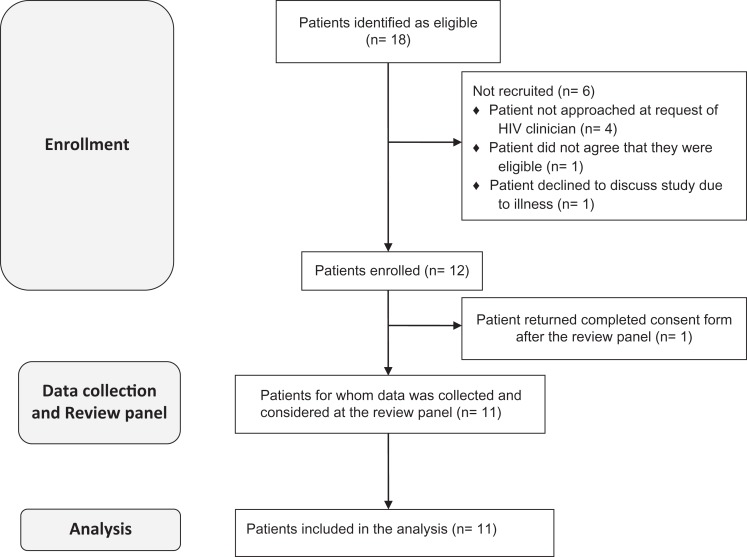
Patient recruitment.